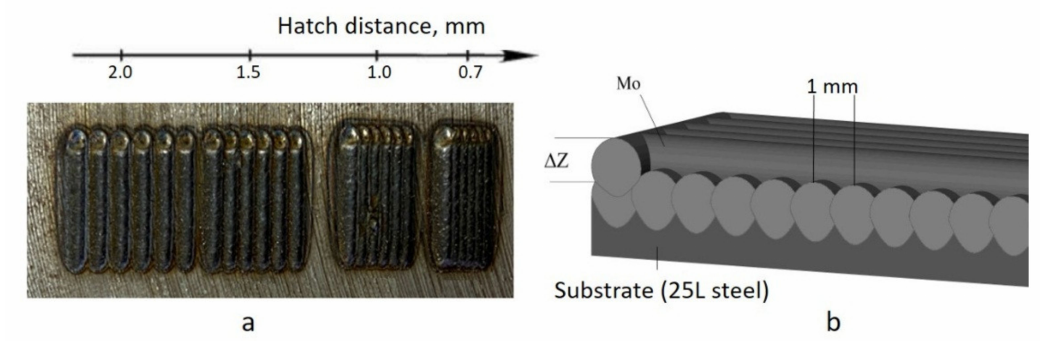
Figure 7. ( a ) General view of the beads according to hatch distance; ( b ) scanning strategy for LDED of the objects.